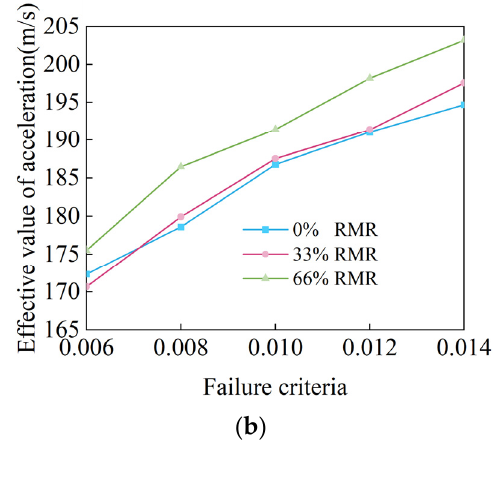
( d ) Figure 12. ( a ) Failure criteria versus effective value of velocity under different RMR. ( b ) Failure criteria versus effective value of acceleration under different RMR. ( c ) Failure criteria versus mean value of velocity under different RMR. ( d ) Failure criteria versus mean value of acceleration under different RMR. 3.2. Influence of Motion Mode on the Vibration Signal The impact behavior between coal gangue particles and hydraulic support studied in the previous section is the simplest contact mode between them. In this section, the